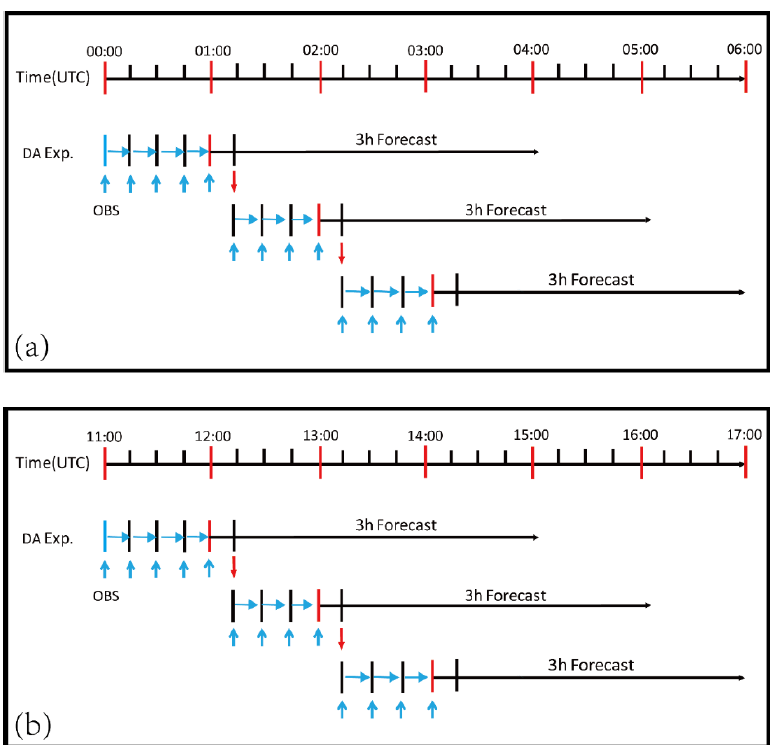
Figure 3. Illustration of data assimilation cycles and forecast cycles used for ( a ) Case 1 and ( b ) Case 2. ‘OBS’ represents the assimilated observations, such as radar velocity and reflectivity, and the pseudo- observations. The observations were assimilated every 15 min, and 3-h forecast launched at 01:00 UTC (12:00 UTC), 02:00 UTC (13:00 UTC) and 03:00 UTC (14:00 UTC) for Case 1 (2). The vertical blue arrows indicate the times at which the observations were assimilated.